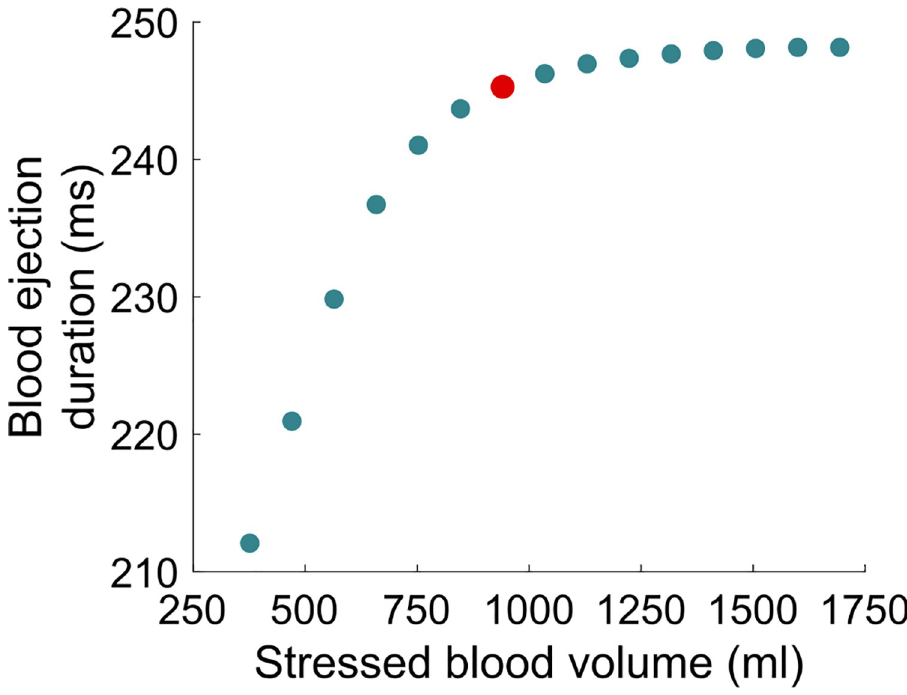
Fig 12. Blood ejection duration during vascular filling